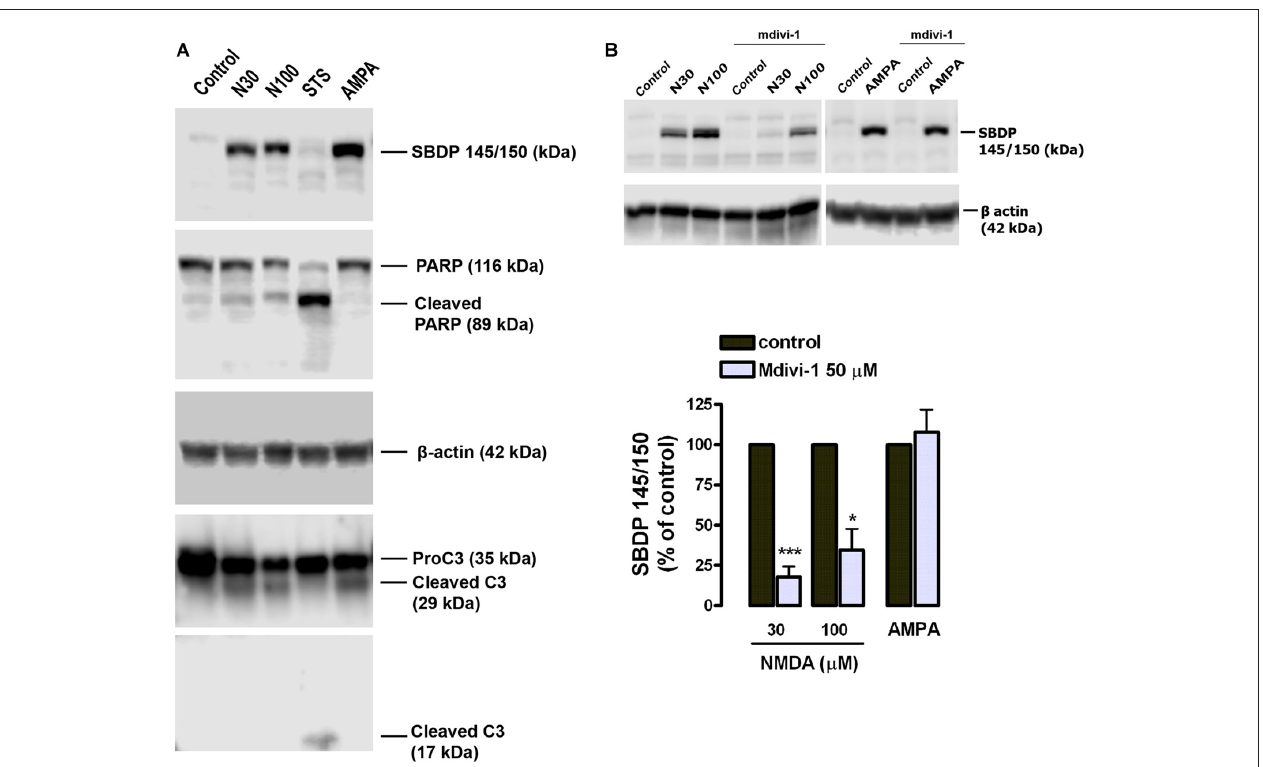
FIGURE 3 | Mdivi-1 reduces NMDA-induced calpain activation. (A) Neurons were exposed to NMDA (30 µ M and 100 µ M, 30 min), staurosporine (STS, 1 µ M) or AMPA (25 µ M, 30 min) plus CTZ (100 µ M) and harvested 24 h later for the detection of α II-spectrin breakdown products (SBDP), cleaved PARP, cleaved caspase-3 and β -actin by western blot. (B) Cells were stimulated with NMDA (30 and 100 µ M, 30 min) and AMPA (25 µ M, 30 min) plus CTZ (100 µ M) with or without mdivi-1 (50 µ M) and harvested 4 h later for the detection of 145 and 150 kDa SBDP. For the quantification of calpain activation, SBDP150/145 signal was measured and normalized to β -actin values. ∗ p < 0.05, ∗∗∗ p < 0.01 compared with NMDA 30 µ M ( n = 5) and NMDA 100 µ M ( n = 4) alone or AMPA/CTZ ( n = 3) alone, paired Student’s t